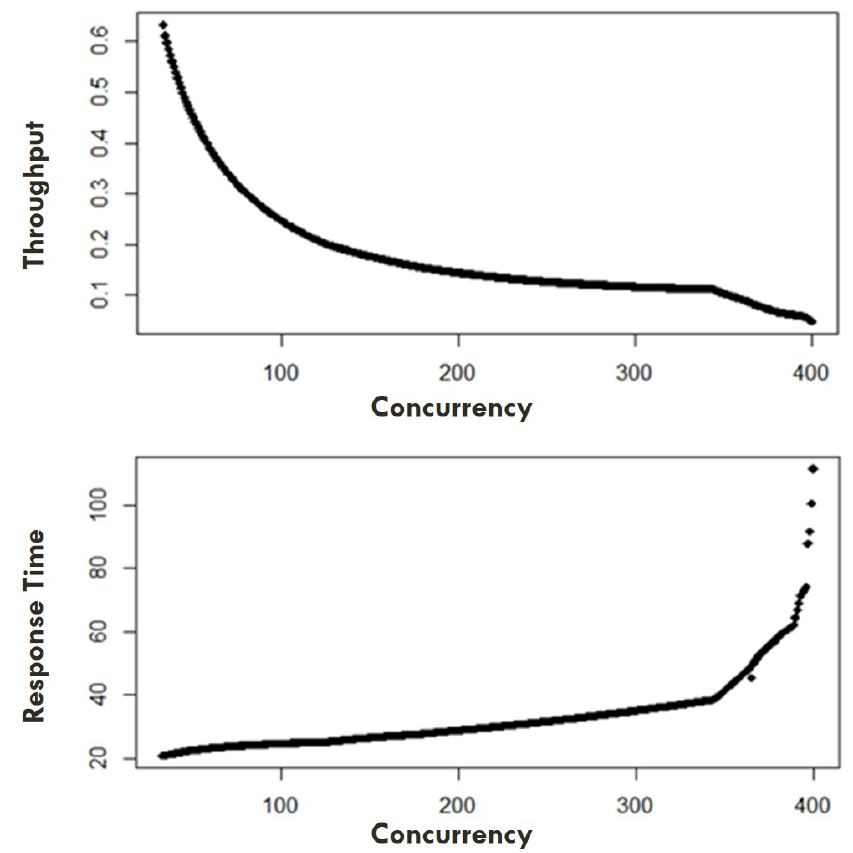
Figure 4. Response time, Throughput to Concurrency .